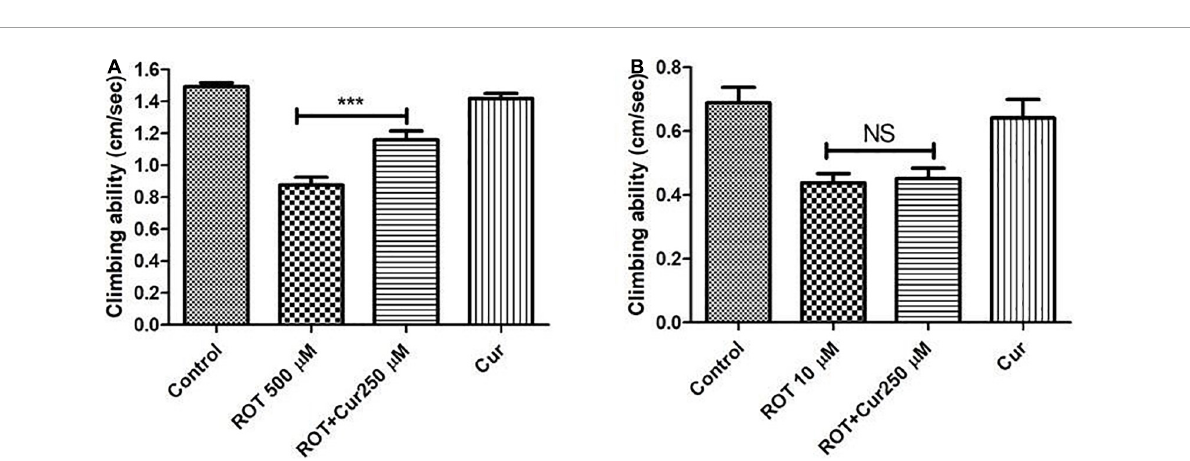
FIGURE6 Negative geo-taxis assay of early health phase and transition phase fly in co-feeding regime: Feeding the fly with ROT alone led to a significant reduction in climbing ability which could be significantly improved upon co-feeding with 250 µ M curcumin during the early health phase (A) but not during the transition phase (B) of the fly. Climbing ability was assessed on the 5th day for the early health phase fly, while it was assessed on the 2nd day in case of the transition phase. Feeding the fly with curcumin per se did not affect the mobility. One-way ANOVA followed by the Newman–Keuls Multiple Comparison Test showed a significant difference in mobility. *** p < 0.0001; NS, Not significant.